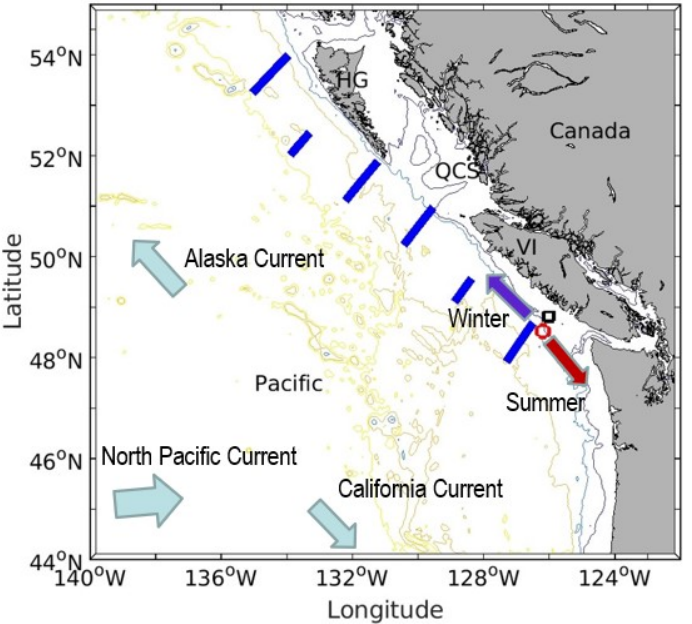
Figure 1. The study area showing the location of six transects (thick blue segment), a long-term monitoring site A1 (red circle), and a buoy site (black square), as well as bathymetry (200-, 1000-, 2500- and 3000-m isobaths). The altimetry data on each transect are used to calculate the surface current averaged over the transect. HG: Haida Gwaii; QCS: Queen Charlotte Sound; VI: Vancouver Island. The six transects from south to north are the South Vancouver Island transect, the North Vancouver Island transect, the Queen Charlotte Sound transect, the South Haida Gwaii transect, the Central Haida Gwaii transect, and the North Haida Gwaii transect. The schematic mean surface circulation pattern in the Northeast Pacific is depicted (grey arrows), along with the schematic surface shelf-edge flow in summer (red arrow) and winter (blue arrow).